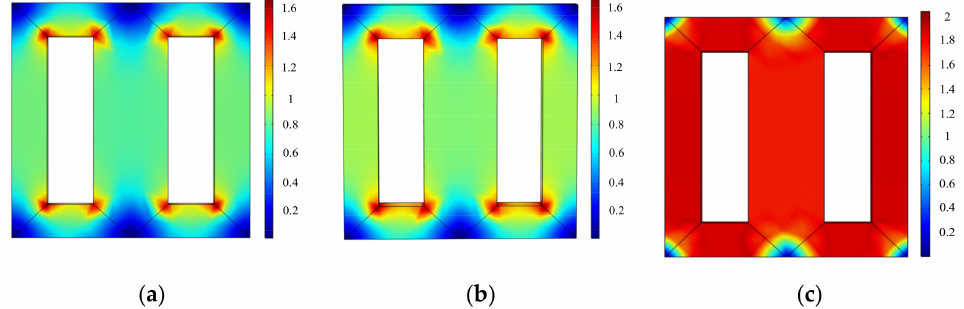
Figure 11. Magnetic flux density distributions of the laminated core: ( a ) Sinusoidal excitation ( B 1 = 0.8 T); ( b ) the fifth harmonic accounts for 50% of the fundamental component in the hybrid harmonic excitation ( B 1 = 0.8 T, B 5 = 0.4 T); ( c ) DC bias of 1A ( B 1 = 0.8 T, H dc = 76 A /